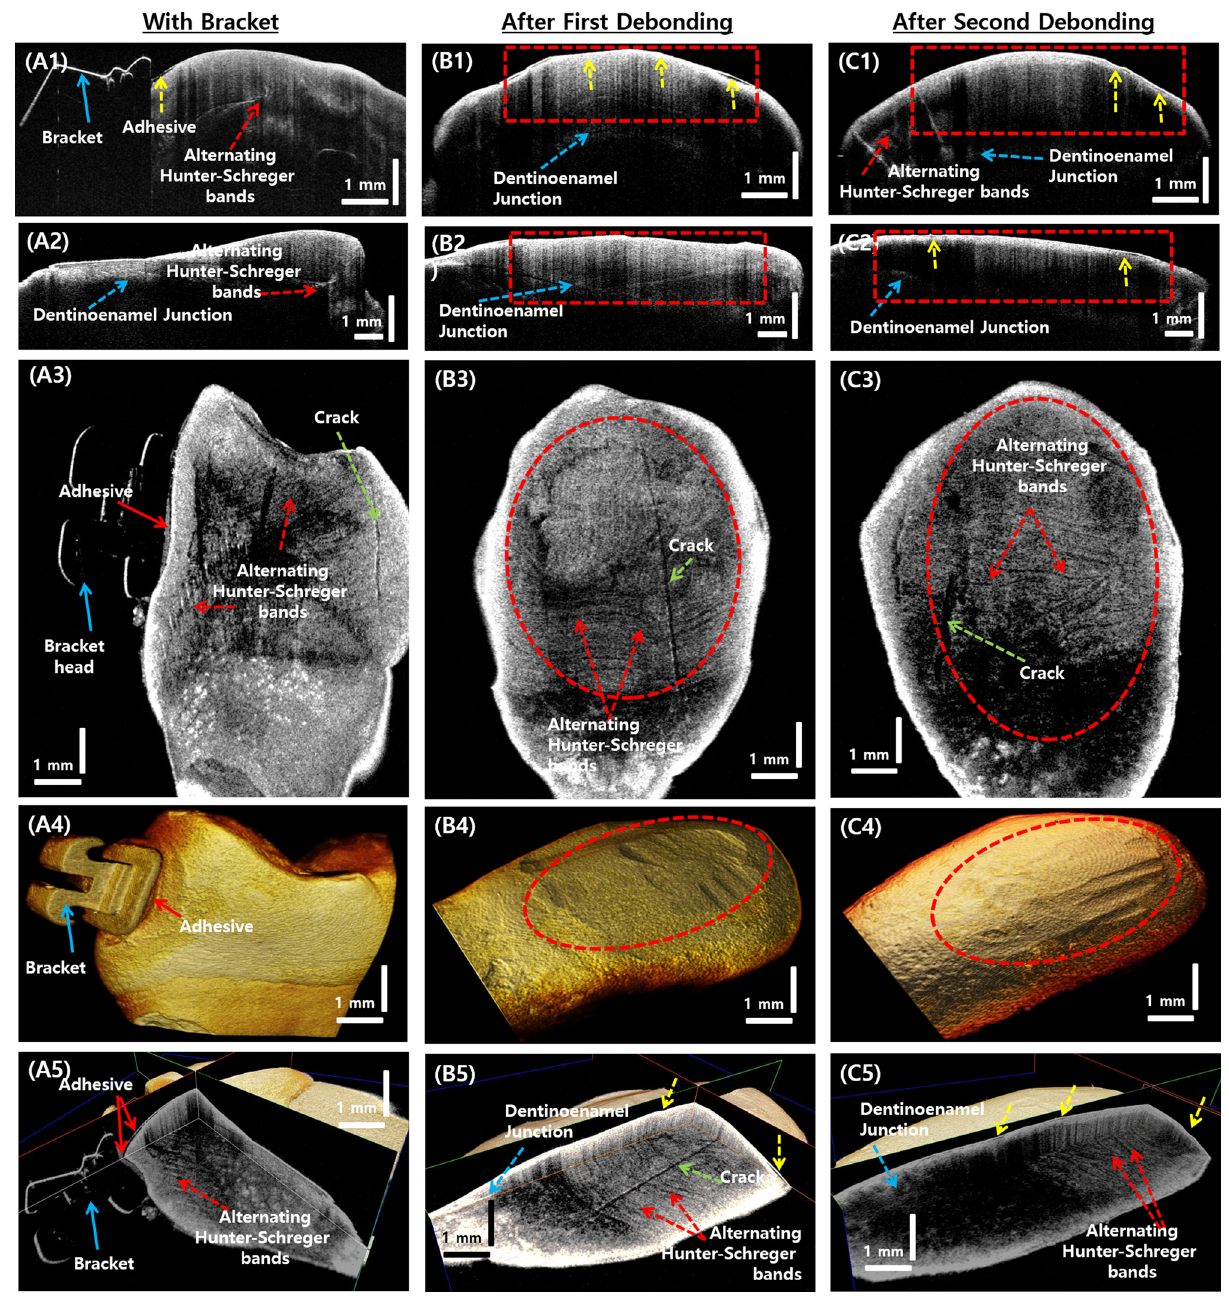
Figure 6. 2D and 3D OCT images of tooth samples after bracket bonding, firstdebonding of the bracket, and second debonding of the bracket. ( A1–A5 ) are the OCT images of a tooth sample after bracket bonding, ( B1 – B5 ) are the OCT images of a tooth sample after the first debonding of the bracket, and ( C1–C5 ) are the OCT images of a tooth sample after second debonding from a tooth sample. Regions within the rectangular and circular dashed areas indicate the parts of the tooth surface that underwent the treatment